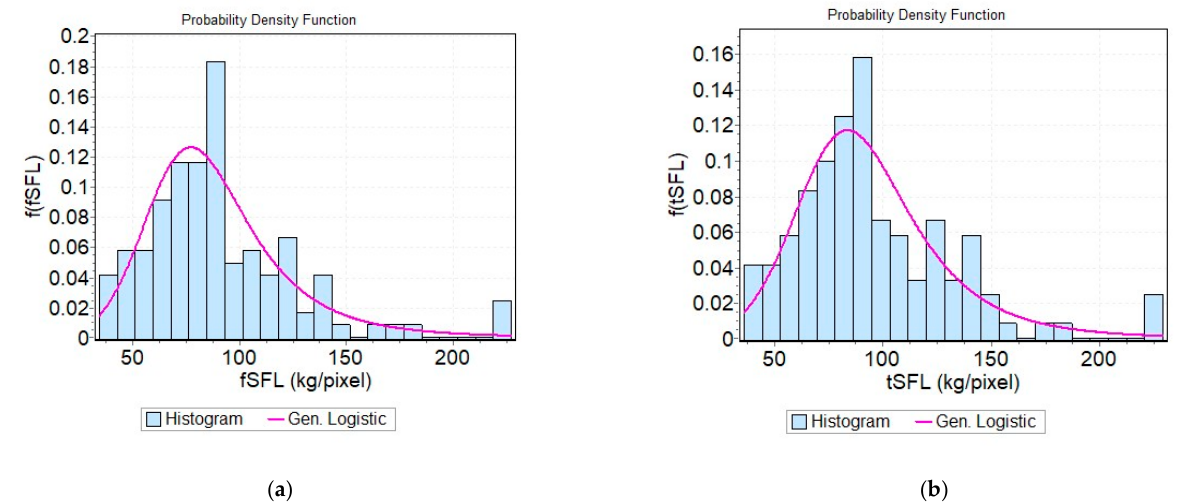
Figure 12. Probability density function of the observed values of surface fuel mass. The distribution of inventory fuel mass data is GL(tSFL; 0.1804, 18.57, 90.04) ( a ) and GL(fSFL; 0.2109, 17.38, 84.35) ( b ) where the x -axis is the observed value of fuel loads and the y -axis is the percentage frequency of individual fuel loads.